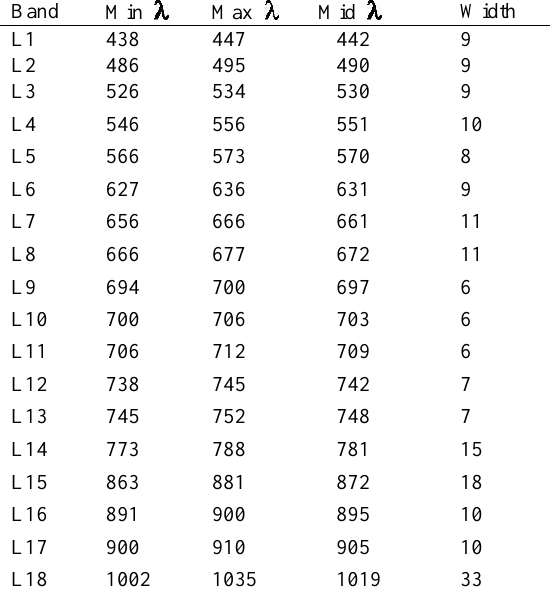
Table 2. Band settings of CHRIS land surface detection mode (MODE3) (unit: nm)